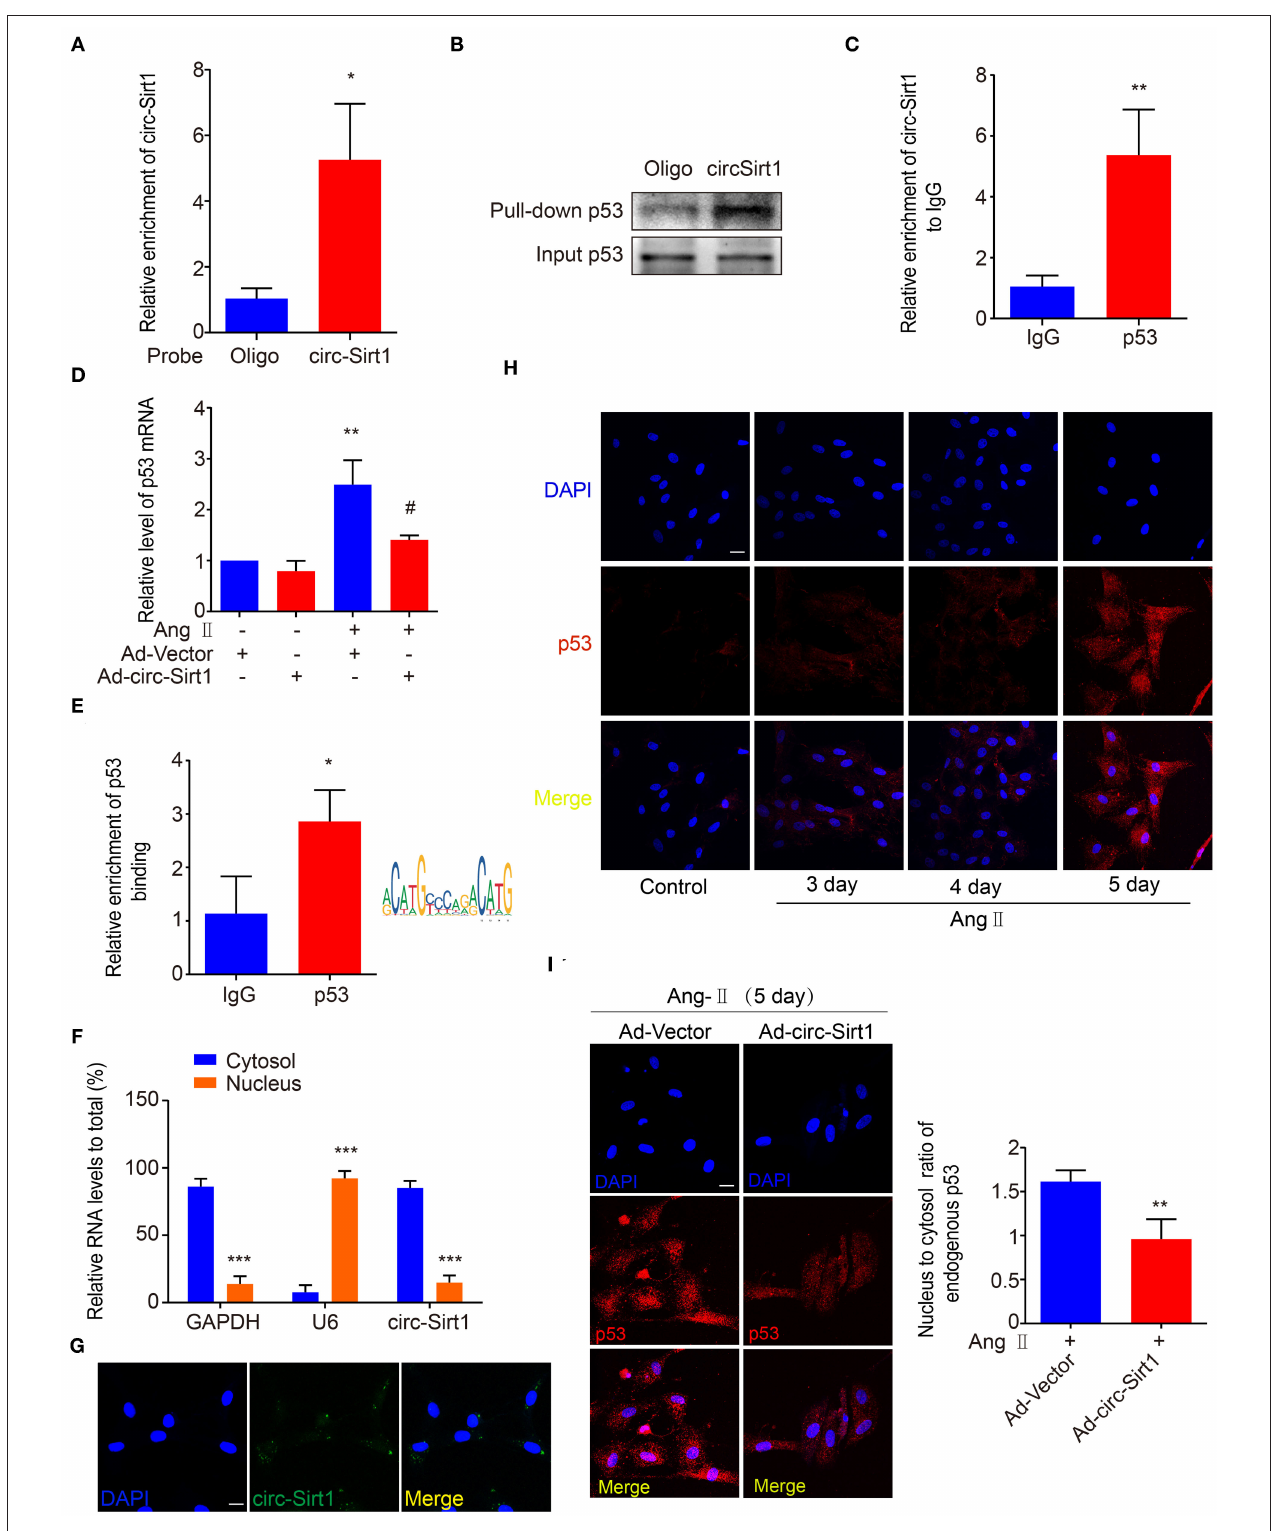
FIGURE 3 | circ-Sirt1 interacts with and anchors p53 in the cytoplasm. (A) The probe specifically bound to circ-Sirt1. (B,C) RNA pull-down (B) and Rip (C) assays were performed to validate the interactions between circ-Sirt1 and p53 in senescent VSMCs. (D) The mRNA level of p53 decreased in senescent VSMCs